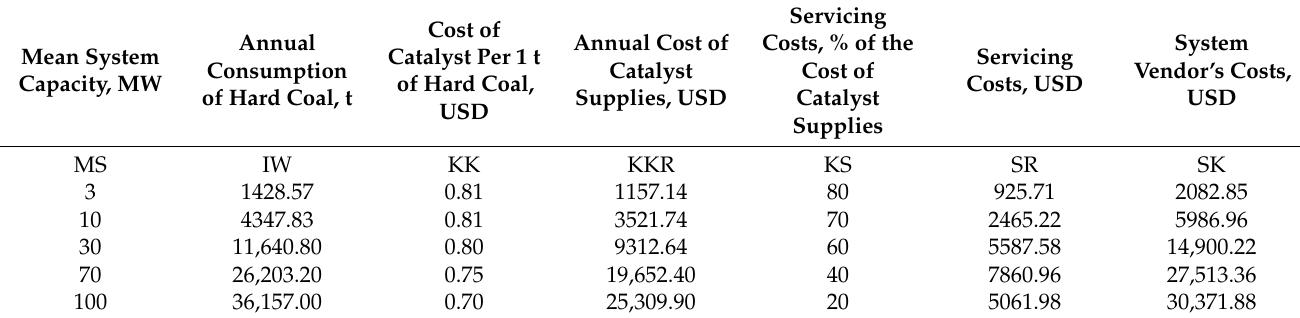
Table 7. The costs of the vendor of the components of the system that improves coal-combustion energy efficiency.